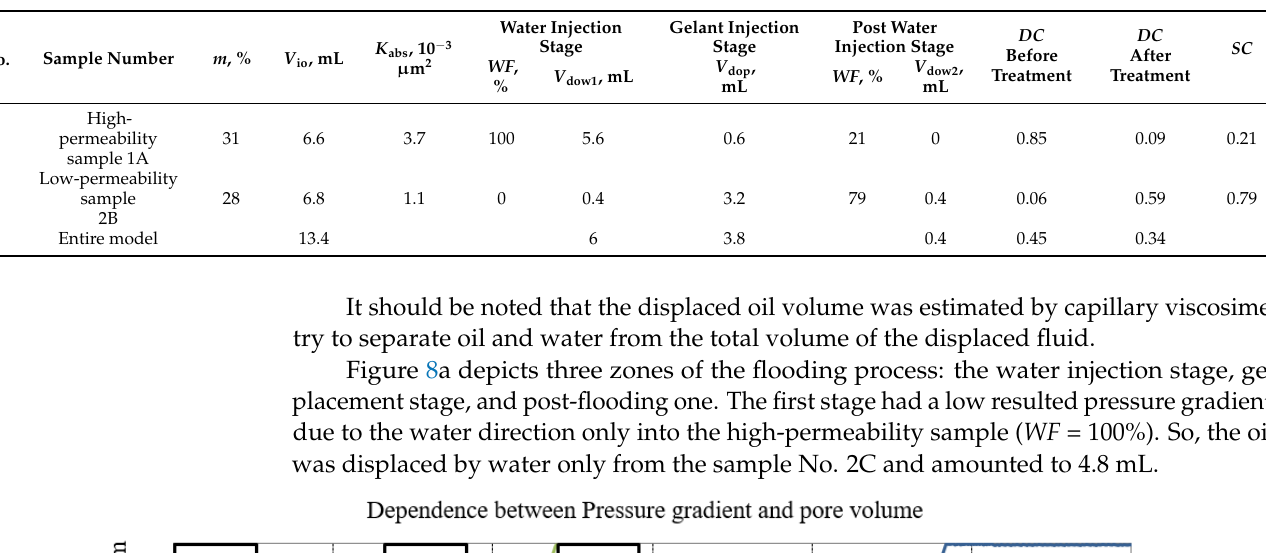
Table 10. Examination of the polymer composition with a gel-time modifier.